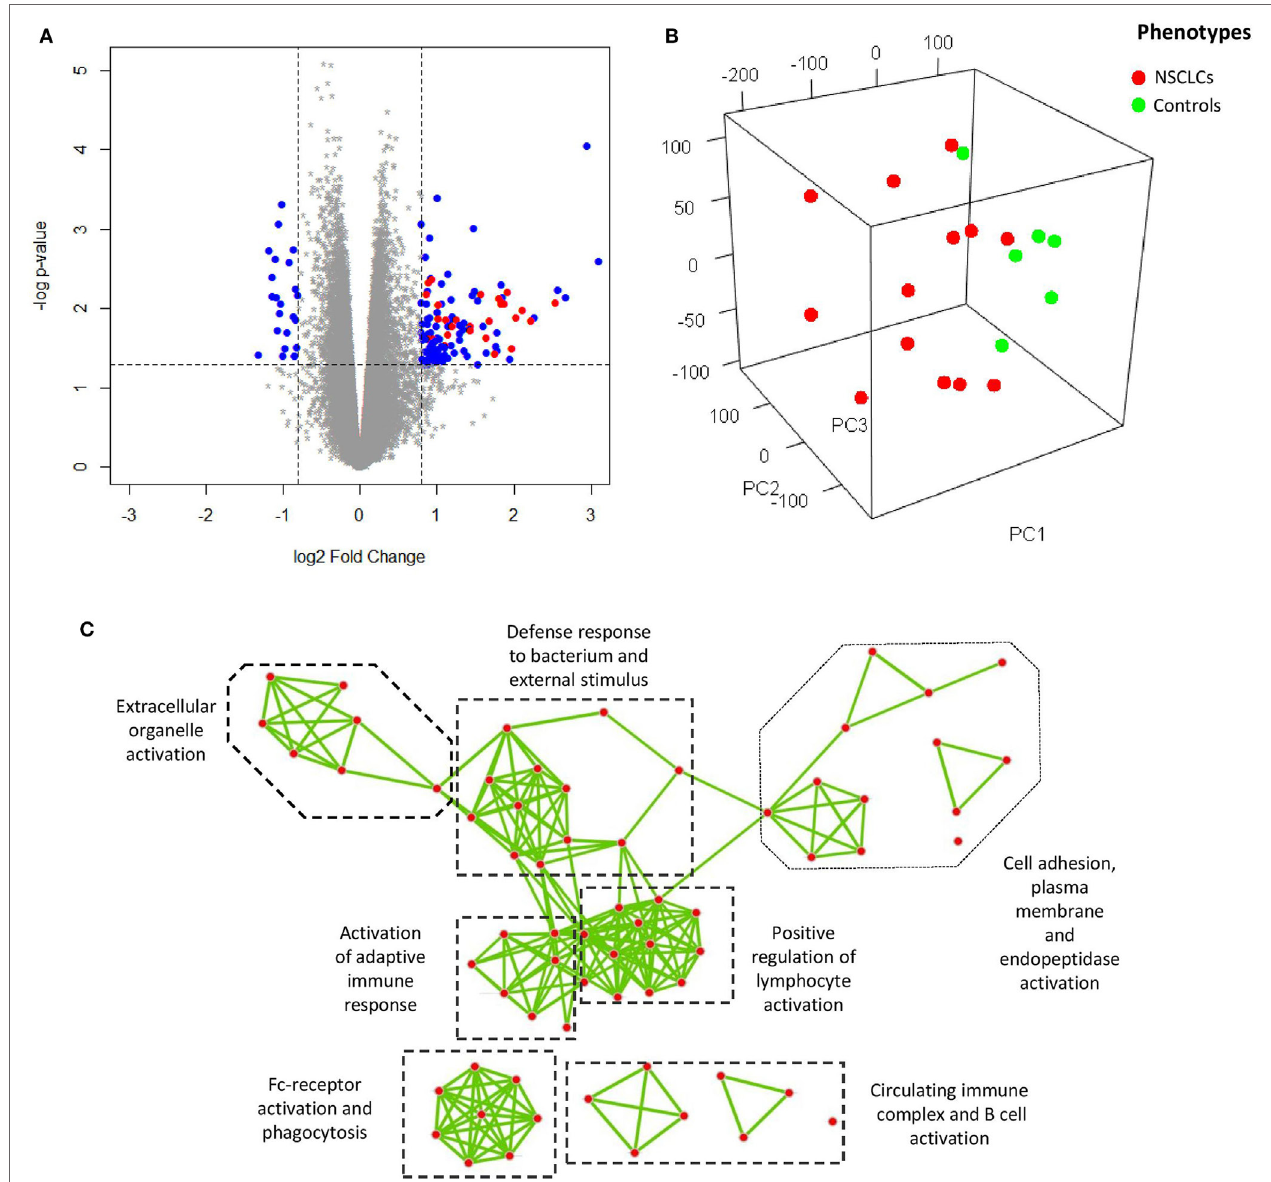
FigUre 2 | (a) Volcano plot showing differentially expressed genes (DEGs) (blue and red) of bronchoalveolar lavage cells. Overexpression of a subset of genes encoding immunoglobulin (red) is shown. (B) Visualization of the expression matrix by principle component analysis from all microarray probe sets of discovery group, where the advanced non-small cell lung cancer (NSCLC) patients (red) versus the controls (green) delineated the major source of variation along the principle component 1 (PC1). (c) Network visualization of gene ontology enrichment analysis for the DEGs. Each node represents an enriched GO-term and each edge represents the presence of overlapping genes between two